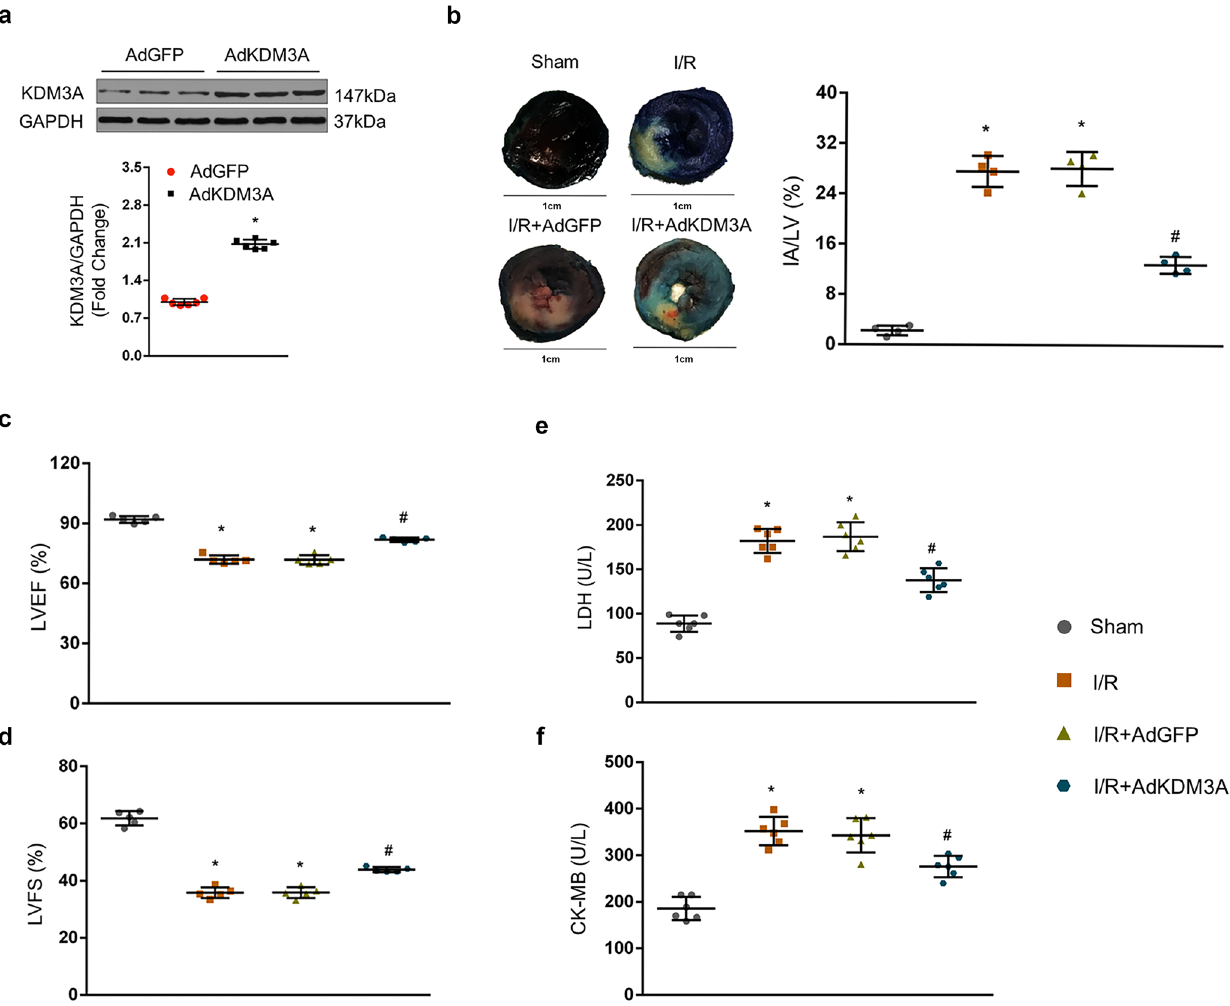
Fig. 2 KDM3A overexpression protects the myocardium against I/R injury. a Protein levels of KDM3A in rats intramyocardially transduced with AdKDM3A or AdGFP ( n = 6, * P < 0.05 vs. AdGFP). Top: representative blots; bottom: quantitative results. b Representative section images (left panel) and averaged data of the ratio of IA to total left ventricular area (right panel) (detected by Evans blue + TTC staining) ( n = 4, * P < 0.05 vs. I/R). The Evans blue- stained area (dark blue) represents the nonischemia/reperfusion area; TTC/Evans blue-negative regions (pale white) represent the infarcted myocardium. Scale bar = 1 cm. c , d Echocardiographic results of left ventricle ejection fraction (LVEF) and fractional shortening (LVFS) indicated cardiac function after KDM3A upregulation in response to MIRI or sham operation ( n = 5, * P < 0.05 vs. sham; # P < 0.05 vs. I/R or I/R + AdGFP). e , f Myocardial death was estimated by the serum LDH/CK-MB concentrations with or without MIRI ( n = 6, * P < 0.05 vs. sham; # P < 0.05 vs. I/R or I/R +